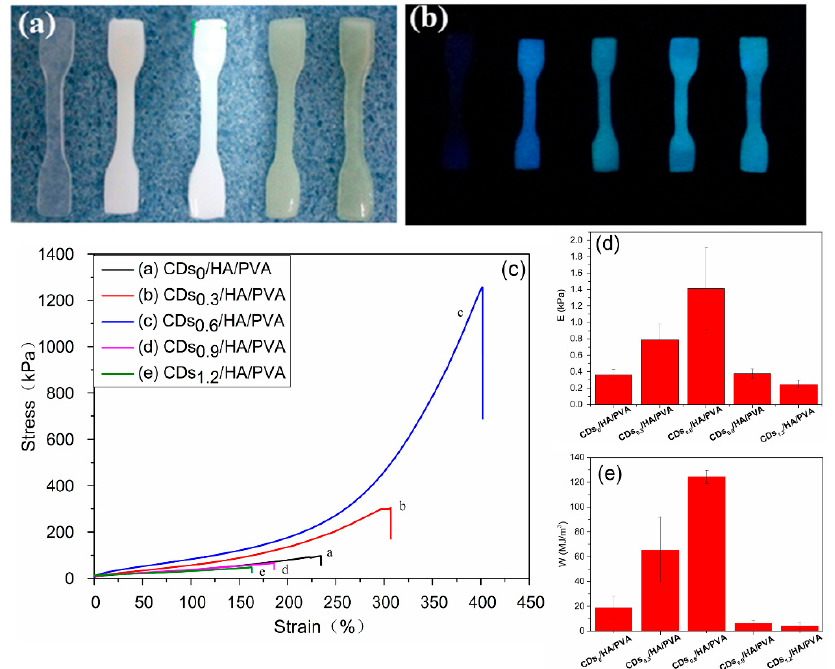
Figure 4. The tensile test-piece of the CDs/HA/PVA SN hydrogels with increasing mass ratios of CDs/PVA (0.0%, 0.3%, 0.6%, 0.9%, and 1.2%, respectively, from left to right ( a ) in the sunlight and ( b ) under UV light. ( c ) The tensile stress ‒ strain curves, ( d ) Young’s modulus, and ( e ) fracture energy of the CDs/HA 0.6 /PVA SN hydrogels with different mass ratios of CDs to PVA at 0.0%, 0.3%, 0.6%, 0.9%, and 1.2%, respectively.